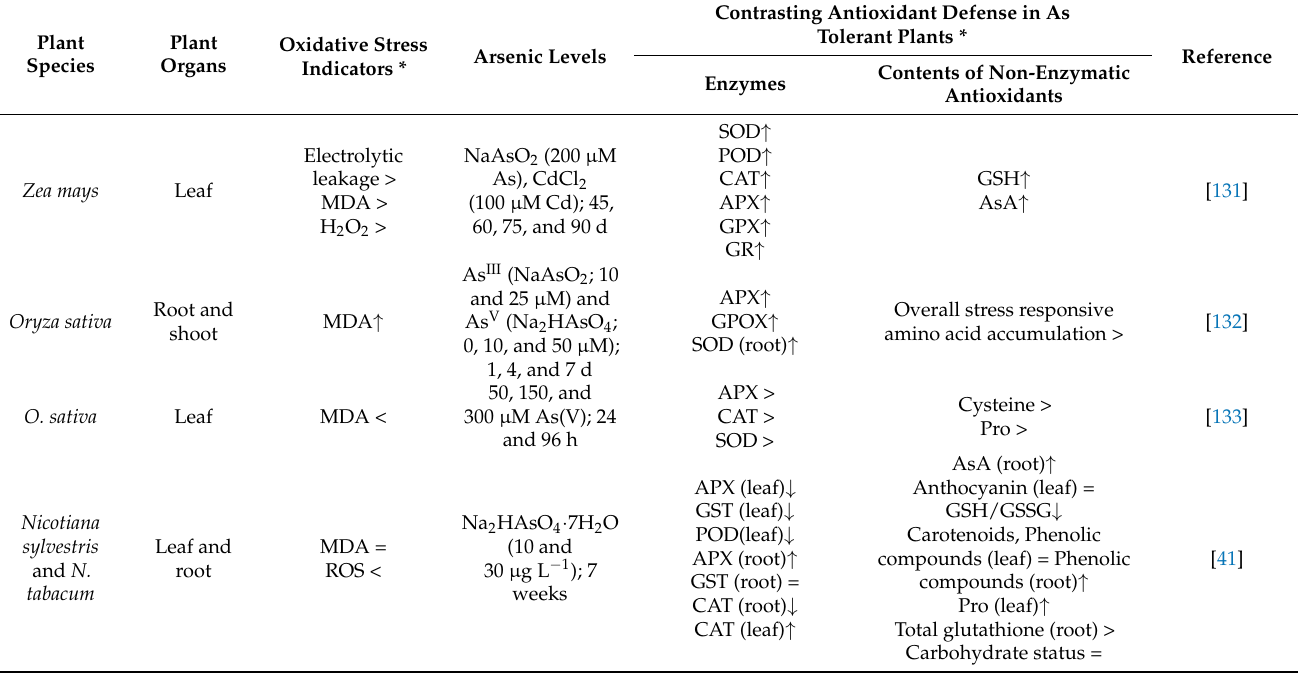
Table 3. Examples of studies involving the evaluation of antioxidant molecules in contrasting plants for arsenic